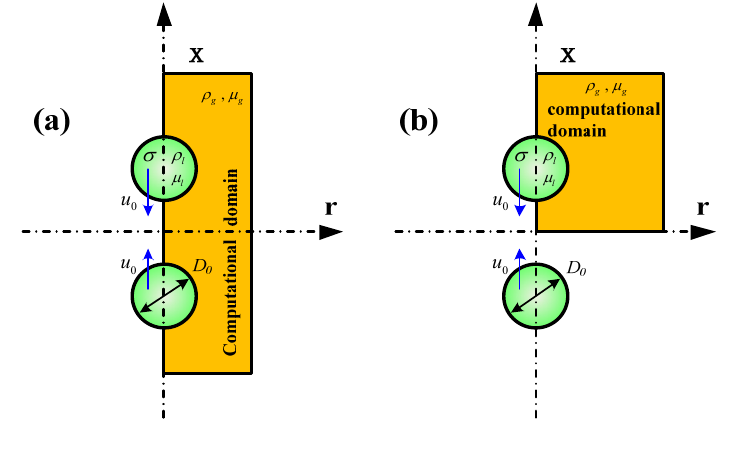
Figure 2. The physical problem and the computational domain. The size of the computational domain ( a ) and ( b ) are 0.3 mm × 1.0 mm and 0.8 mm × 0.5 mm,